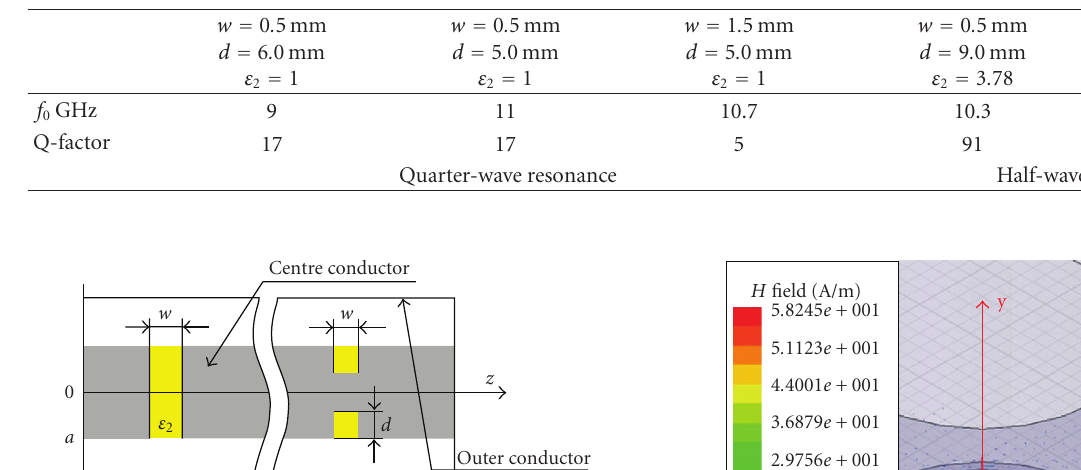
Table 1: Geometrical and physical parameters of the band-rejection element.